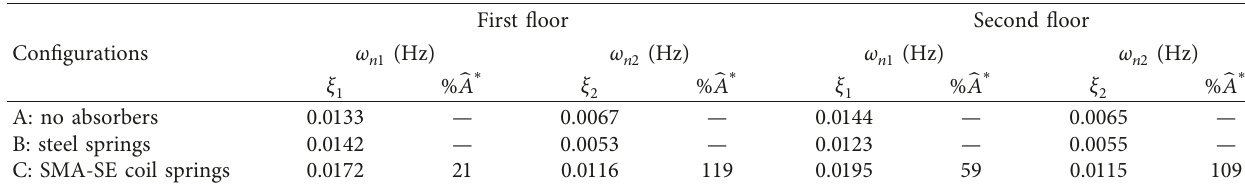
Table 7: Structural damping of the system in forced vibration, linear scale.